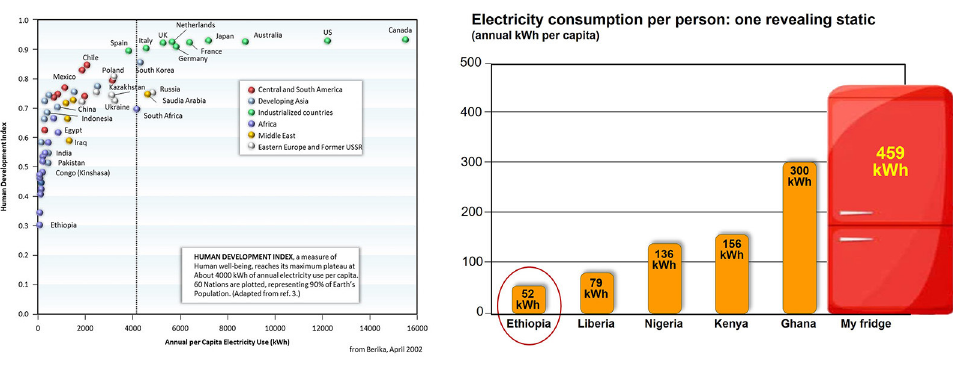
Fig. 2. – Left: human development index vs. annual per capita electricity use for 60 nations, representing 90% of the world’s population. Right: energy consumption per person (annual kWh per capita) in selected African countries compared with the annual energy consumption of a domestic